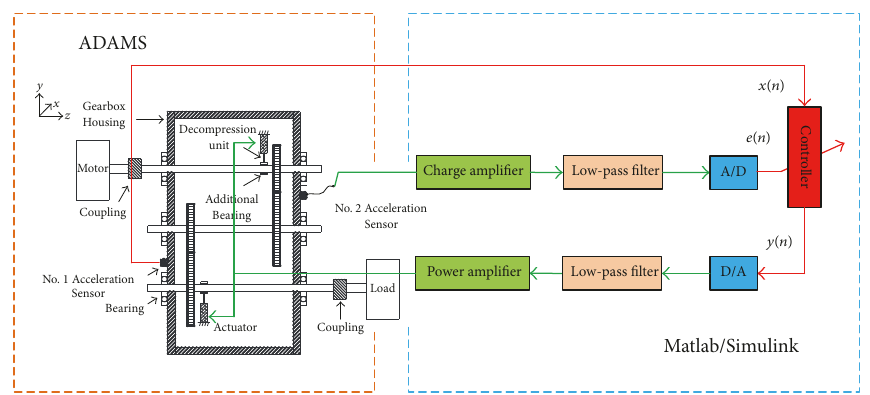
Figure 7: The diagrammatic sketch of the MGTS with controlled system.